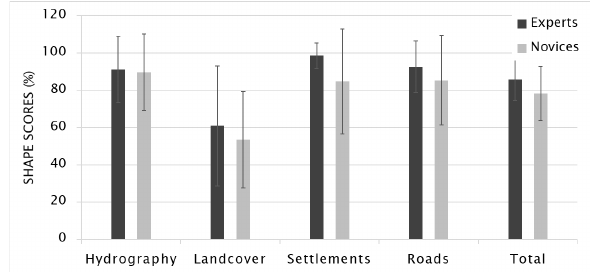
Figure 9. Shape scores (Error bars indicate standard deviation).